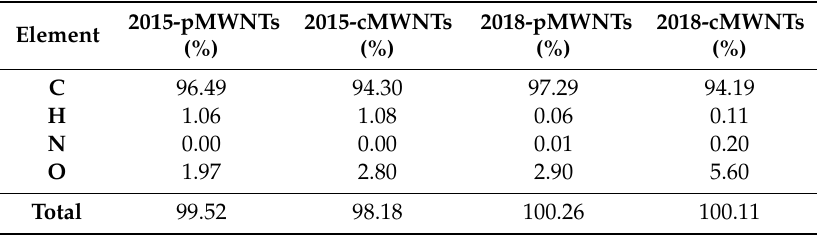
Table 1. CHN / O elemental percentages of the pristine multi-walled carbon nanotube (pMWNT) and carboxylated MWNT (cMWNT) powders.